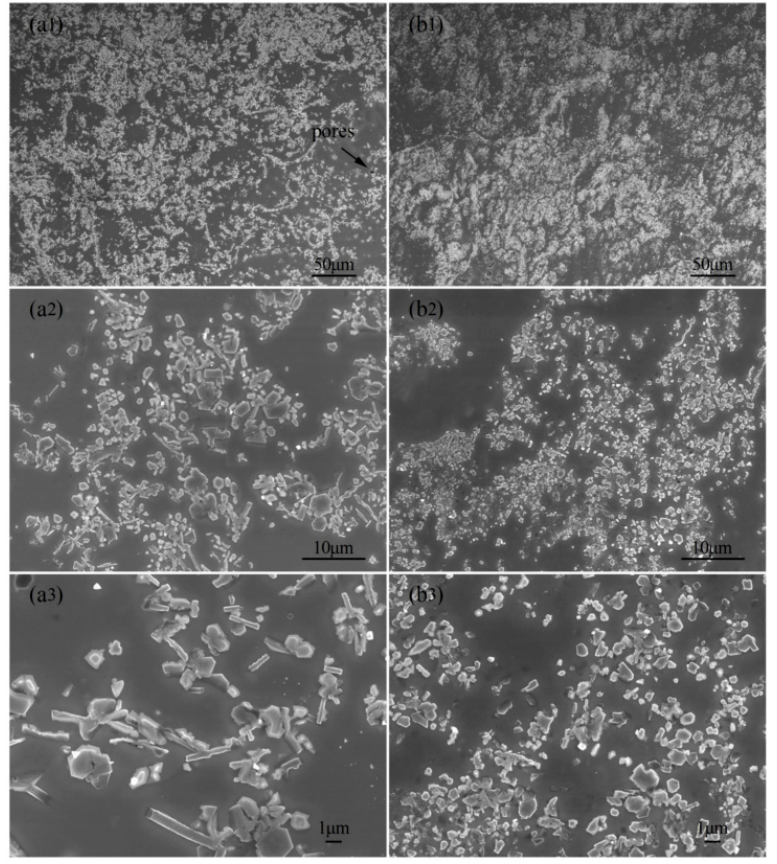
Figure 17. SEM images of as-cast TiB2p(–TiBw)/Cu and TiB2p(–TiBw)/Cu–La composites; ( a1 – a3 ) the as-cast TiB2p(-TiBw)/Cu; ( b1 – b3 ) the as-cast TiB2p(-TiBw)/Cu–La composites